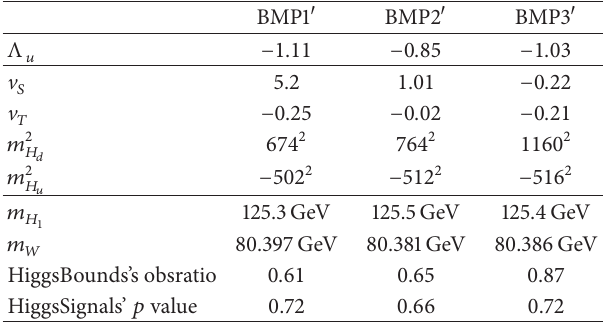
Table 3: Adapted benchmark points; other parameters are as given in Table